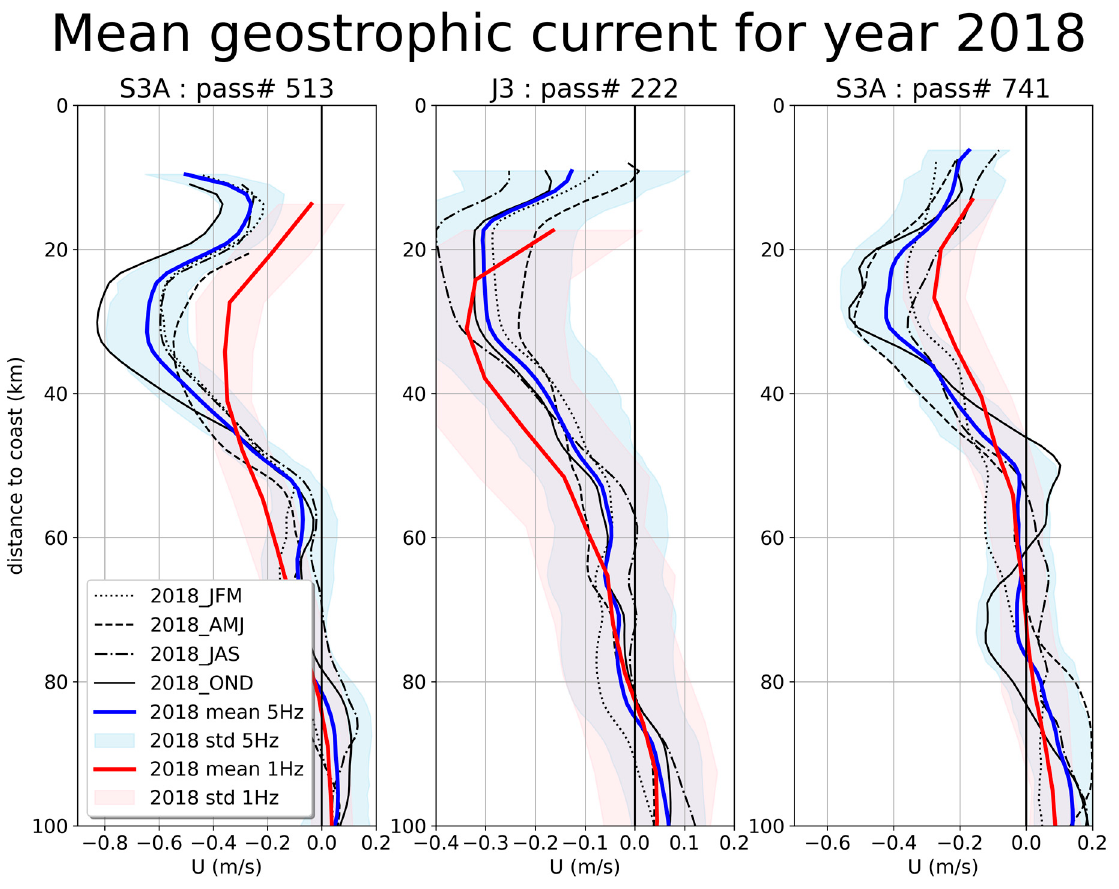
Figure 9. Mean across-track current along the J3 pass #222 ( center ), SA pass #513 ( left ), and #741 ( right ) crossing the NC. The current is displayed as a function of the distance to the coast. Results obtained using 5Hz product—mean over 2018 (blue line) and 2018 seasons (black lines). Mean over year 2018 obtained using 1Hz product (red line). Uncertainty estimation for the 1Hz (light red) and 5Hz (light blue) yearly mean is deduced from the standard deviation of the current over the year.